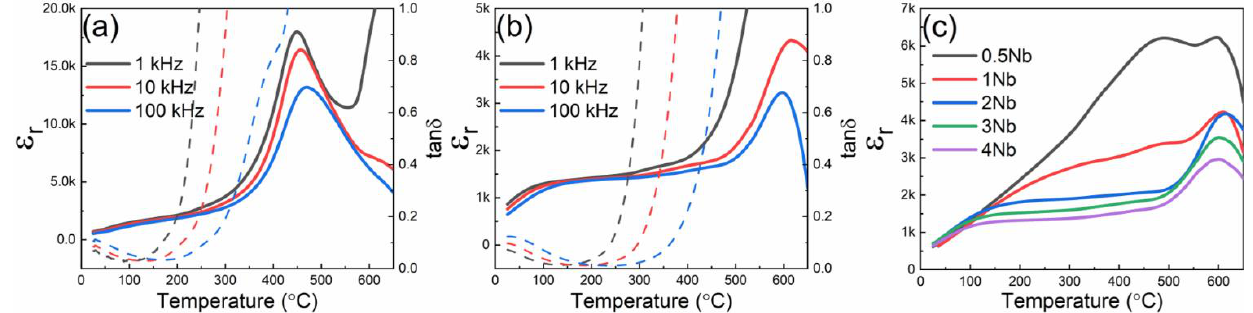
Figure 4. Temperature-dependence of relative dielectric permittivity ( ɛ r ) and loss (tan δ) for ( a ) 0.7BF – 0.3BT – 0Nb ( b ) 0.7BF – 0.3BT – 2Nb and ( c ) 0.7BF – 0.3BT – xNb ceramics, measured at 10 kHz. Dashed lines in ( a ) and ( b ) indicate dielectric loss values.